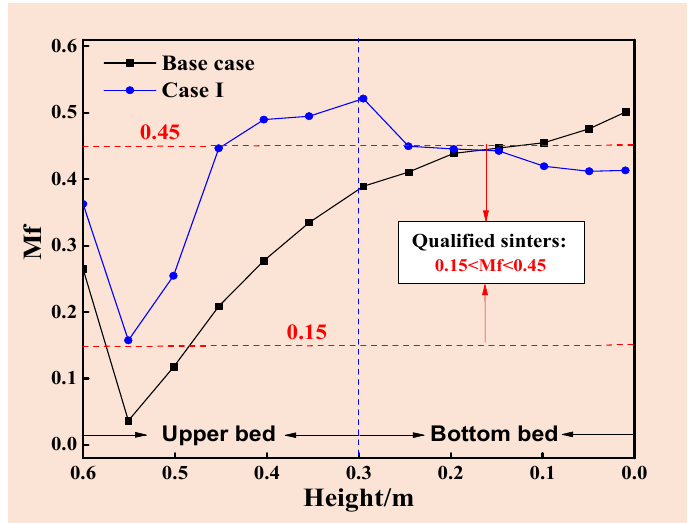
Figure 13. Melting fractions for the CS and FSDS technologies: ( a ) base case; ( b ) case I.